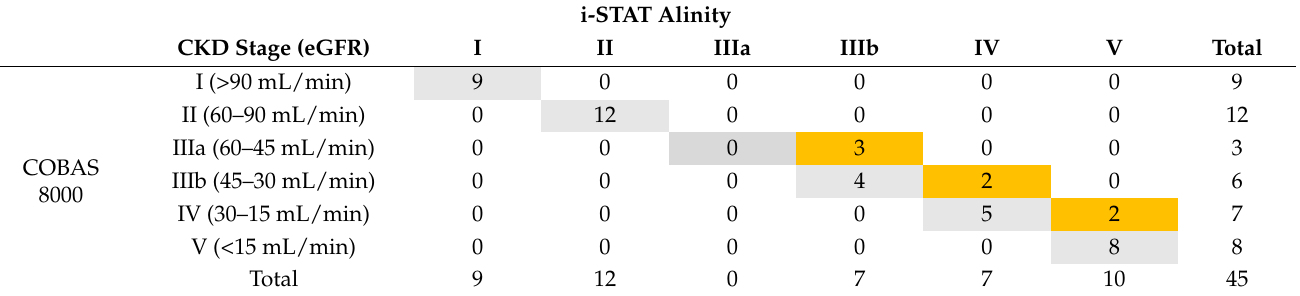
Table 3. Concordance of Chronic Kidney Disease (CKD) staging induced by creatinine measured by the i-STAT Alinity system (Abbott laboratories, Chicago, IL, USA) and Cobas 8000 instrument using a c702 module (Roche Diagnostic, Meylan, France) in 45